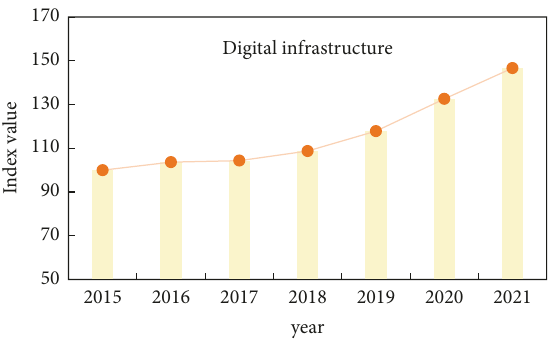
Figure 4: Digital infrastructure evaluation results.